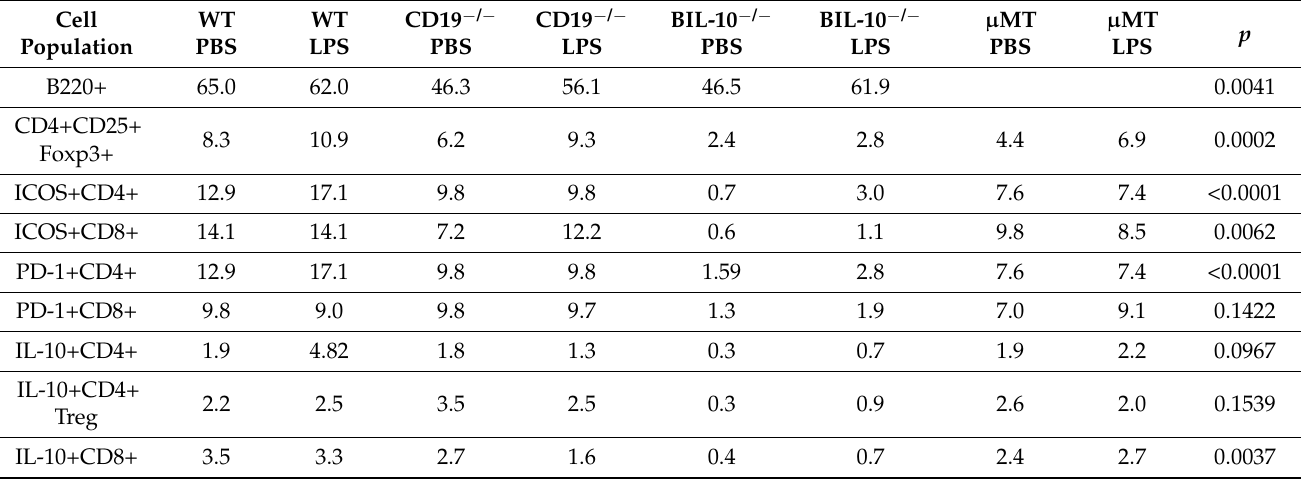
Table 3. Immune cell populations in paraaortic lymph nodes (PLN). Shown are the the mean frequencies of B220+ B cells, ICOS-expressing CD4+ and CD8+ T cells, PD-1-expressing CD4+ and CD8+ T cells as well as IL-10-expressing CD4+, CD4+CD25+Foxp3+ Treg cells and CD8+ T cells in PLN, determined by flow cytometry. N = 4–6 mice/group; the p values were analyzed by